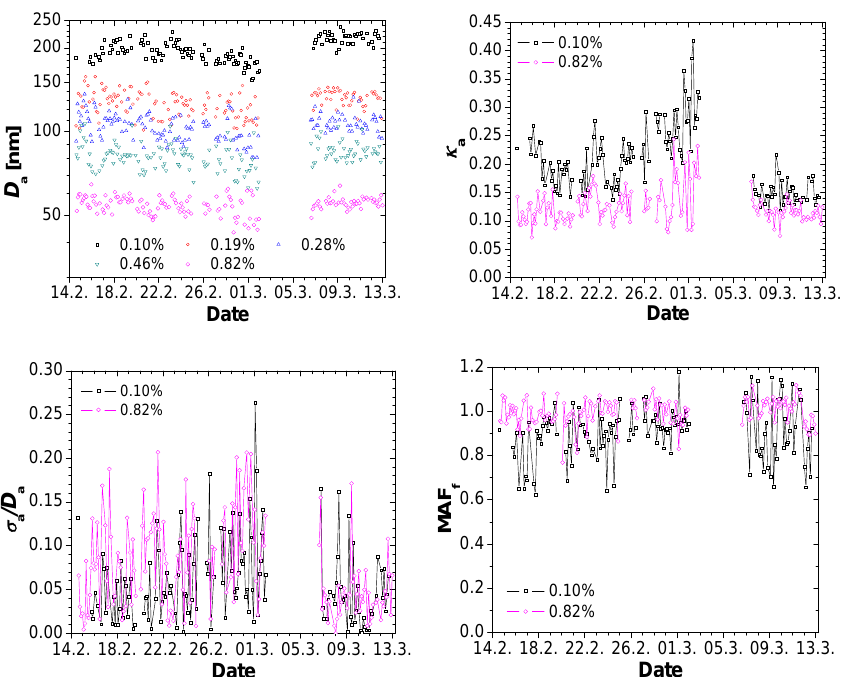
Fig. 4. Time series of characteristic parameters derived from the CCN efficiency spectra (3-parameter CDF fits) observed at different levels of supersaturation ( S =0.10-0.82%) plotted against the date in February–March 2008 (UTC): midpoint activation diameter ( D a ), effective hygroscopicity parameter ( κ a ), heterogeneity parameter ( σ a / D a ), and maximum activated fraction ( MAF f ).